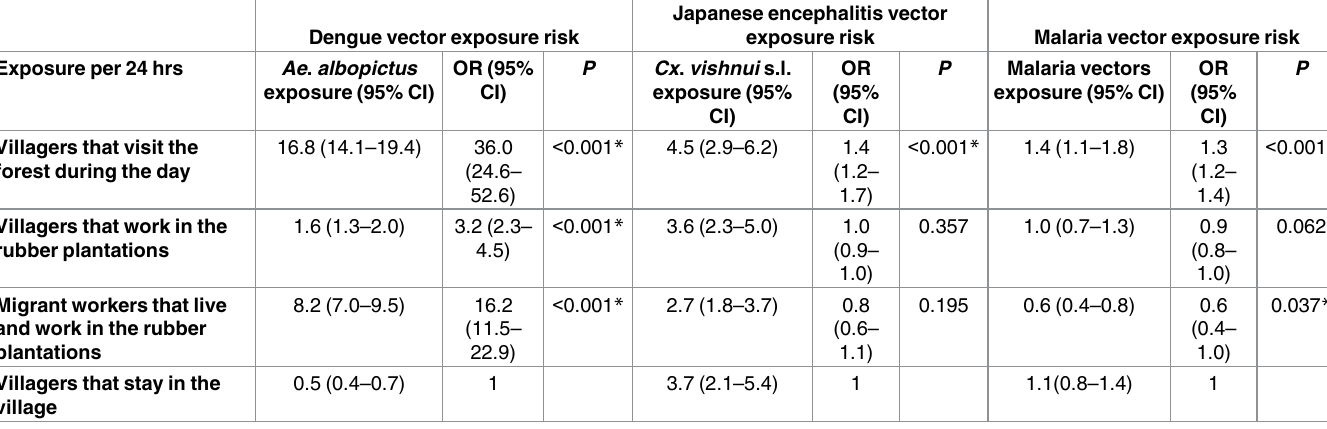
Table 3. The daily risk of exposure to vectorsfor people in different human behavior